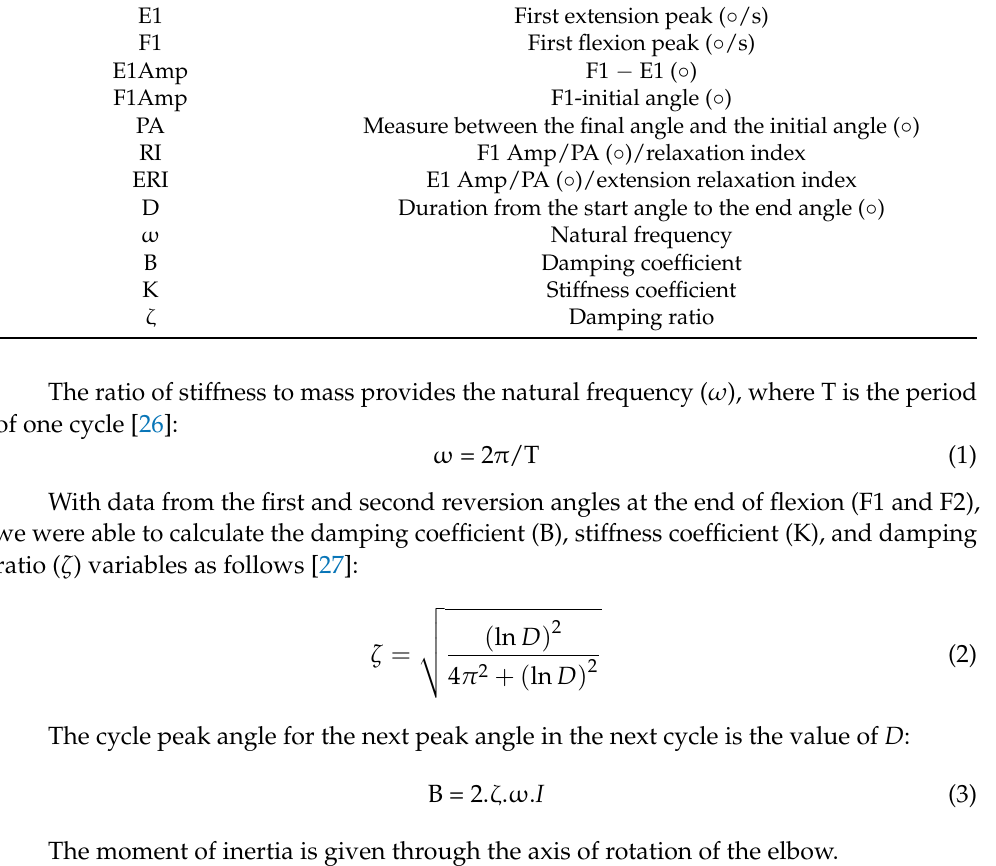
Table 2. Selection of parameters considered for analysis with the inertial sensor. List of Parameters (Measures) E1 First extension peak ( ◦